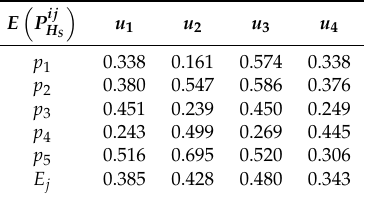
Table 4. The entropy measure of each criterion under each